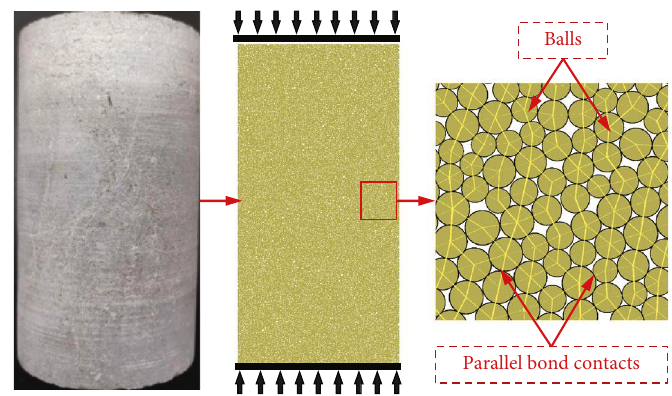
Figure 1: Limestone rock sample and corresponding intact numerical